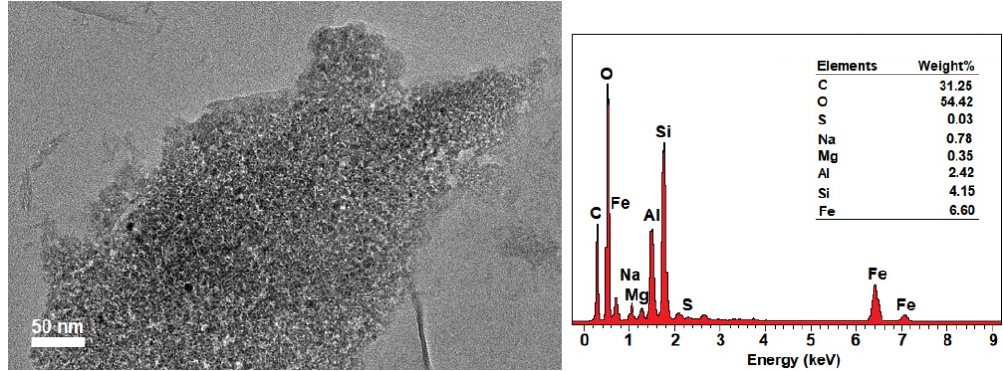
Figure 7. TEM image (scale bar represents 50 nm) and EDX spectrum of MMT / CR / Fe 3 O 4 -PCA (inset: elements composition).